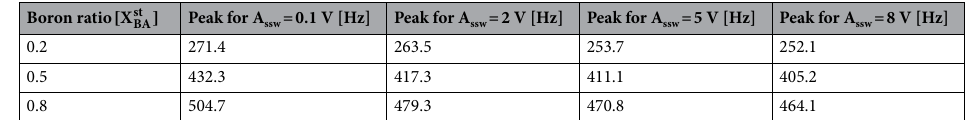
Figure 6. Absorption coefficient measurements, different voltage levels; ( a ) X = 0.8; ( d ) Comparison of sound absorption coefficient measured with different nNAMeGs. X st BA